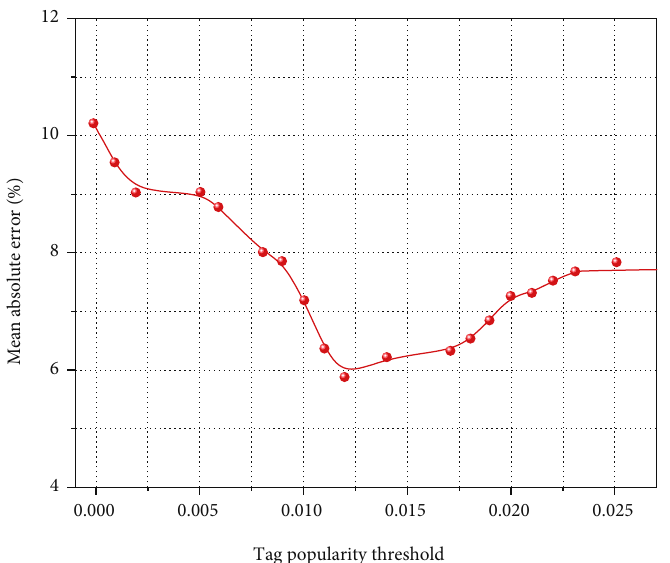
Figure 7: The e ff ect of tag popularity threshold ε on